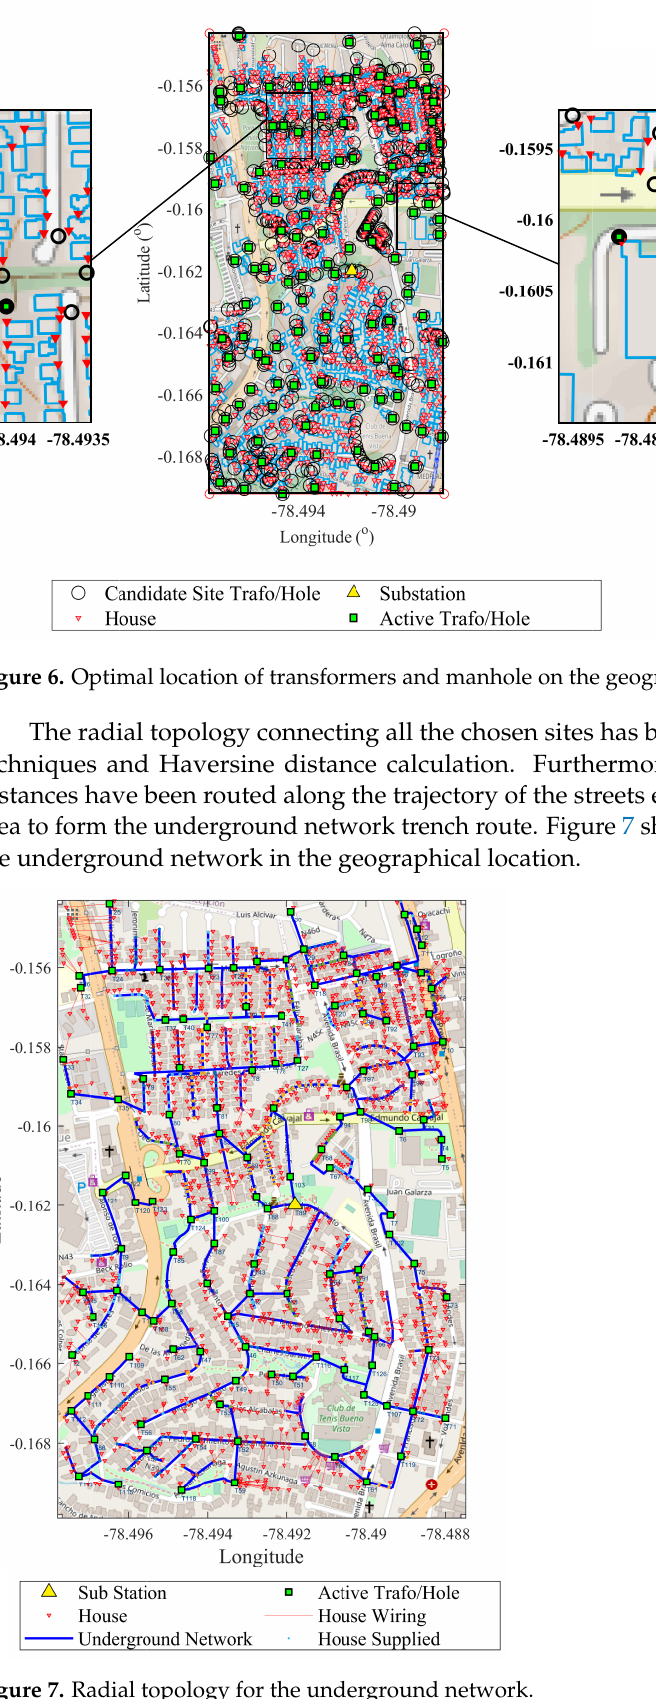
Figure 7. Radial topology for the underground